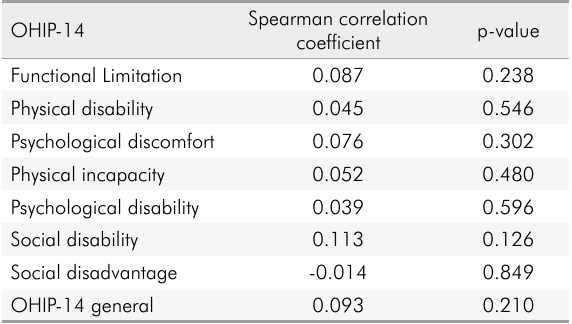
Table 4. Correlation between OHIP-14 and perception of surgical discomfort.